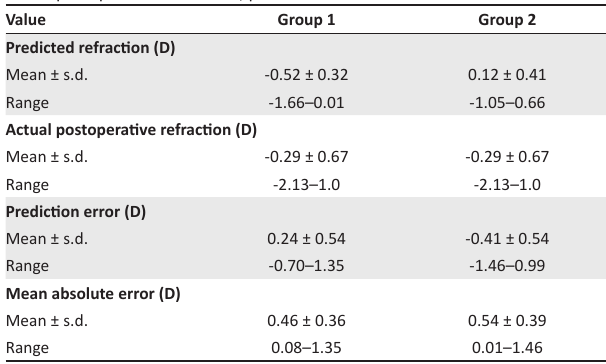
TABLE 3: Mean ± standard deviation and ranges of predicted refractive outcome, actual postoperative refraction, prediction error and mean absolute error.